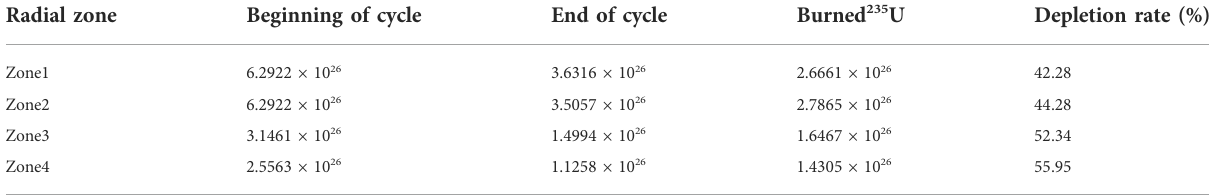
TABLE 2 The change of 235 U number in one refuelling